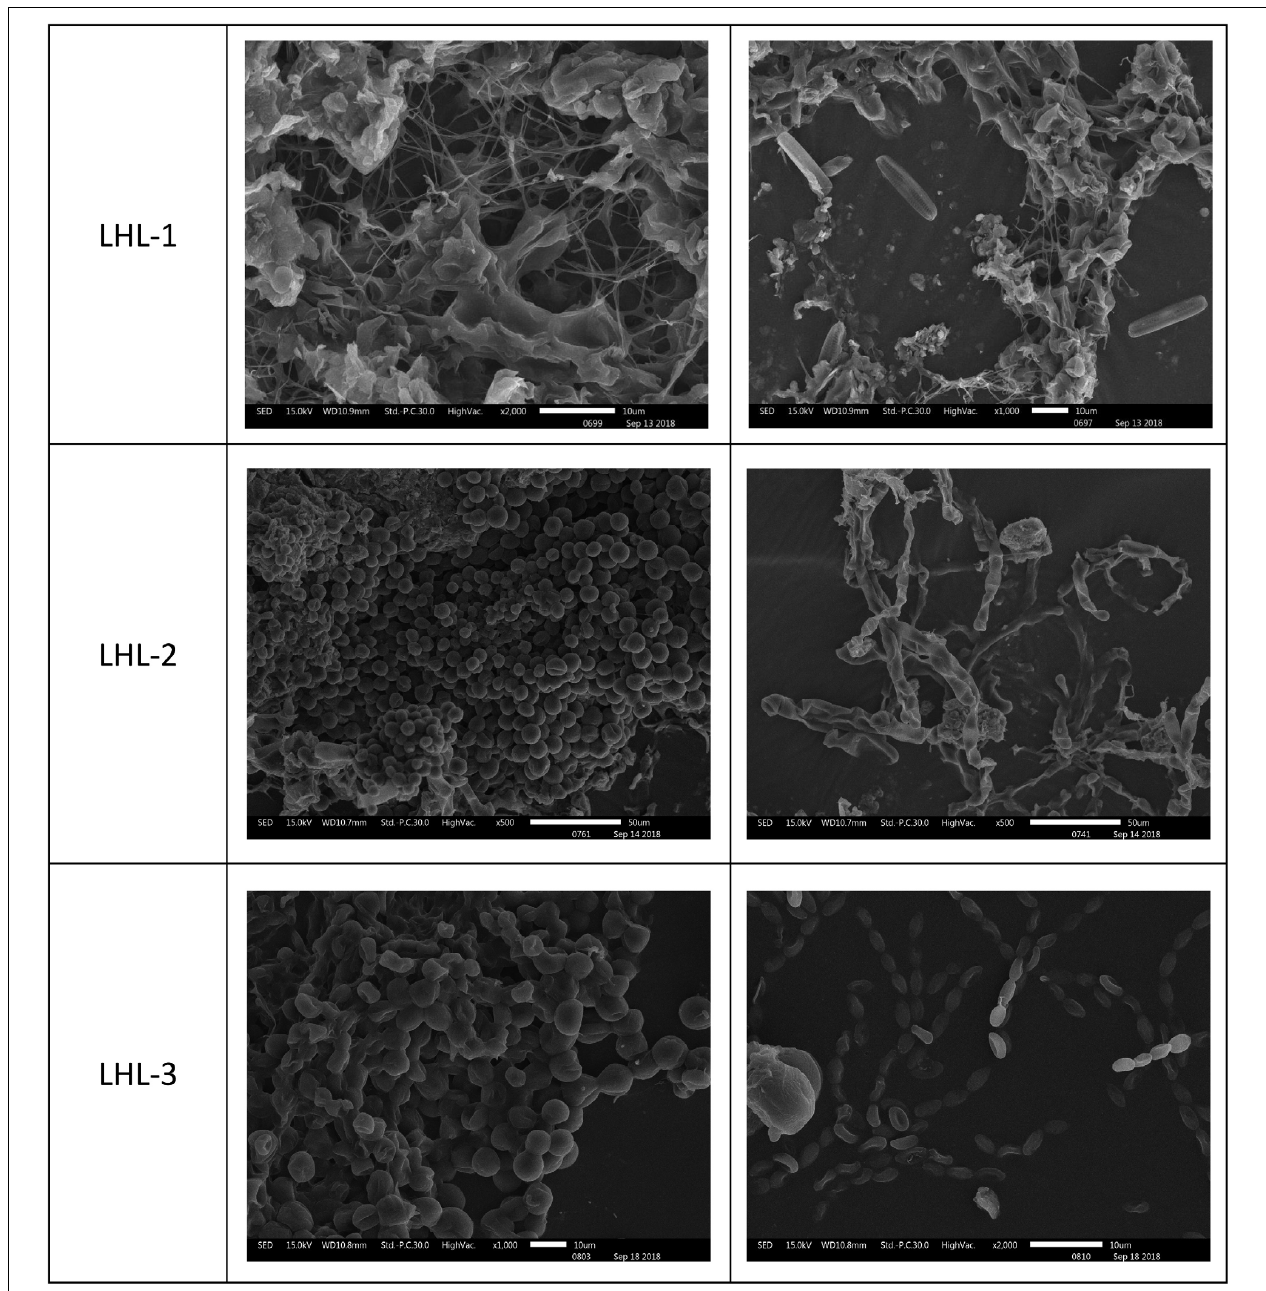
FIGURE 5 | Scanning electron microscopy (SEM) images of a large number of hyphae and cells with a structure similar to algae observed in the